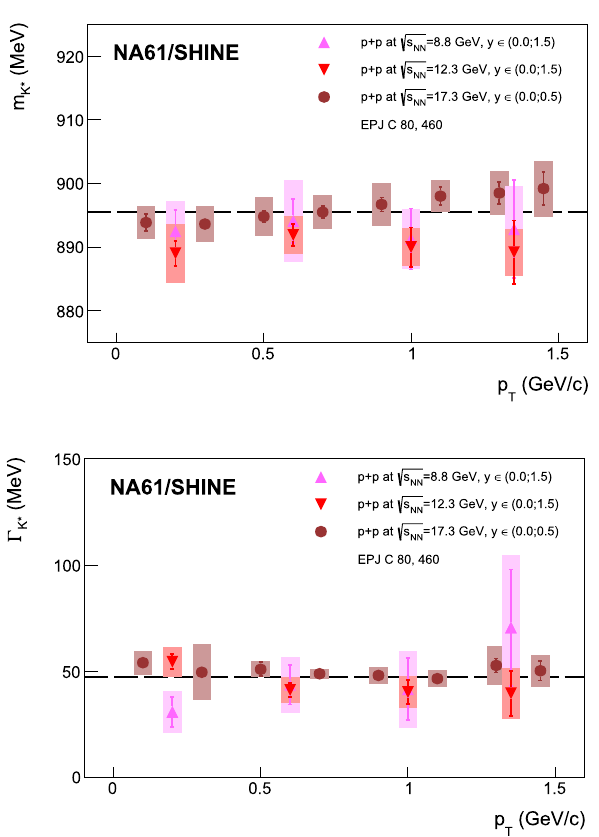
Fig. 5 The transverse momentum dependence of mass (top) and width (bottom) of K ∗ ( 892 ) 0 mesons obtained in inelastic p+p collisions at √ s NN = 8.8 and 12.3 GeV) in rapidity range 40 GeV / c and 80 GeV / c ( 0 < y < 1 . 5. The numerical data are listed in Table 4. The dashed horizontal lines represent PDG values m 0 = 895 . 55 MeV and (cid:5) 0 = 47 . 3 MeV [28]. For a comparison the previous NA61/SHINE results √ s NN = 17.3 GeV) are also [9] for p+p interactions at 158 GeV / c ( shown (they were obtained in 0 < y < 0 .